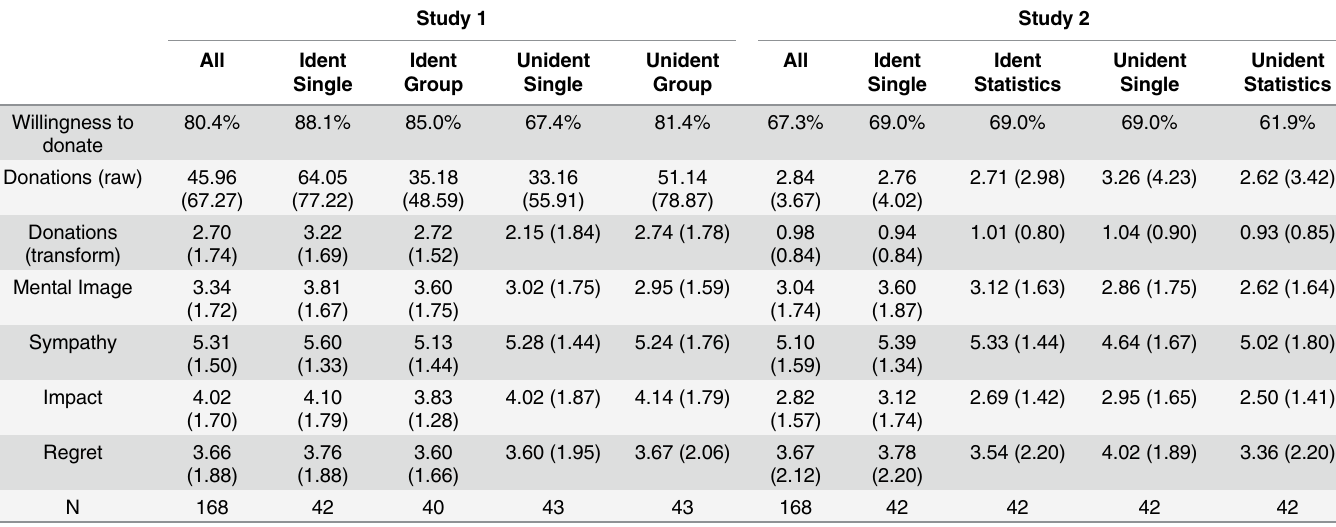
Table 1. Descriptive Statistics for Study 1 and Study